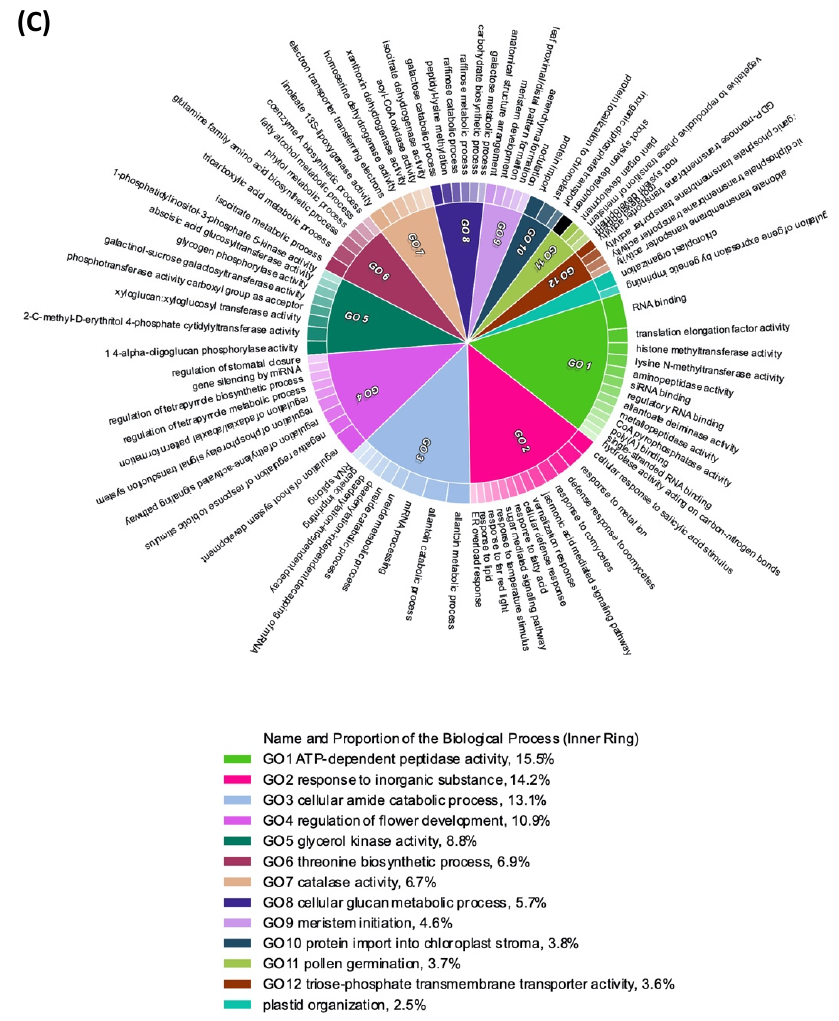
Figure 1. Phenotype and transcriptome analysis of quinclorac-resistant Echinochloa colona (ECO-R). ( A ) Response to quinclorac 21 d after treatment. Photographs of the susceptible genotype ECO-S (left), nontreated and treated (1X field dose), and the resistant genotype ECO-R (right), nontreated and treated (32X field dose). ( B ) Volcano plot depicting the differentially expressed genes in the nontreated ECO-R sample compared to ECO-S. The p value ( − log base 10) for differential gene expression is plotted on the Y-axis. The colored dots on the left indicate genes with significantly downregulated expression and the colored dots on the right indicate genes with significantly upregulated expression. ( C ) CirGO (circular gene ontology) visualization of GO terms enriched in differentially expressed genes in nontreated ECO-R vs ECO-S ( p < 0.05).